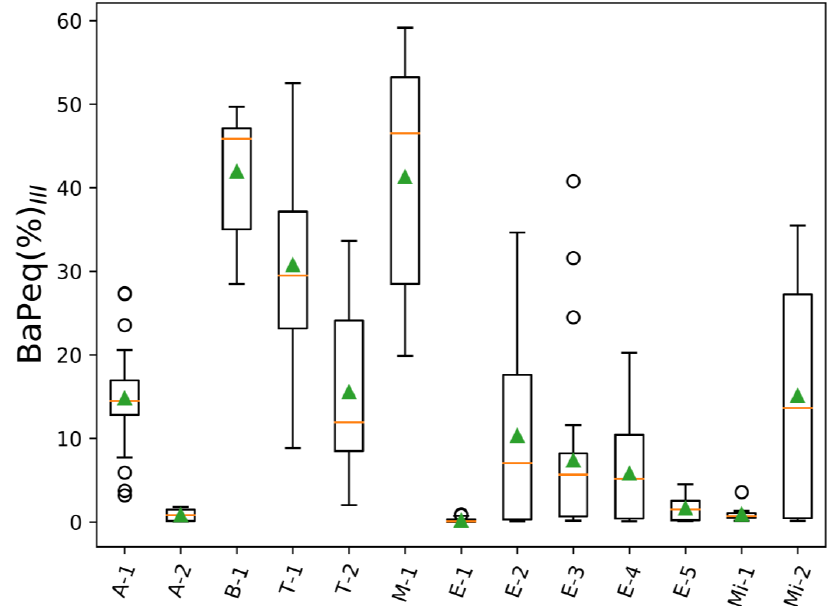
Figure 4. BaPeq ratios of 16 EPA particle-phase PAHs to 88 PAHs for both gas and particle phases: BaP eq (%) III = PM∑ 16EPA BaP eq /(PM + Gas)∑ 88 BaP eq ; orange lines—mean values of BaP eq (%) III ; green triangles—median values of BaP eq (%) III .